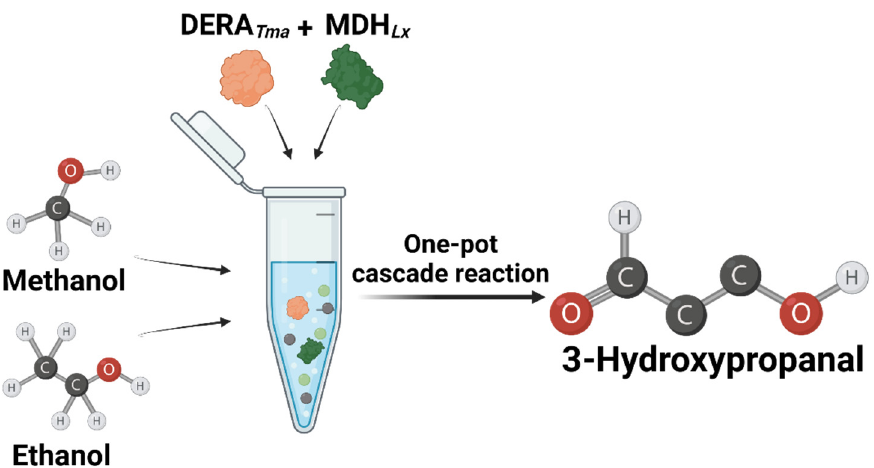
Figure 1. Scheme of the synthetic pathway of 3-hydroxypropanal from methanol and ethanol using DERA Tma and MDH Lx .